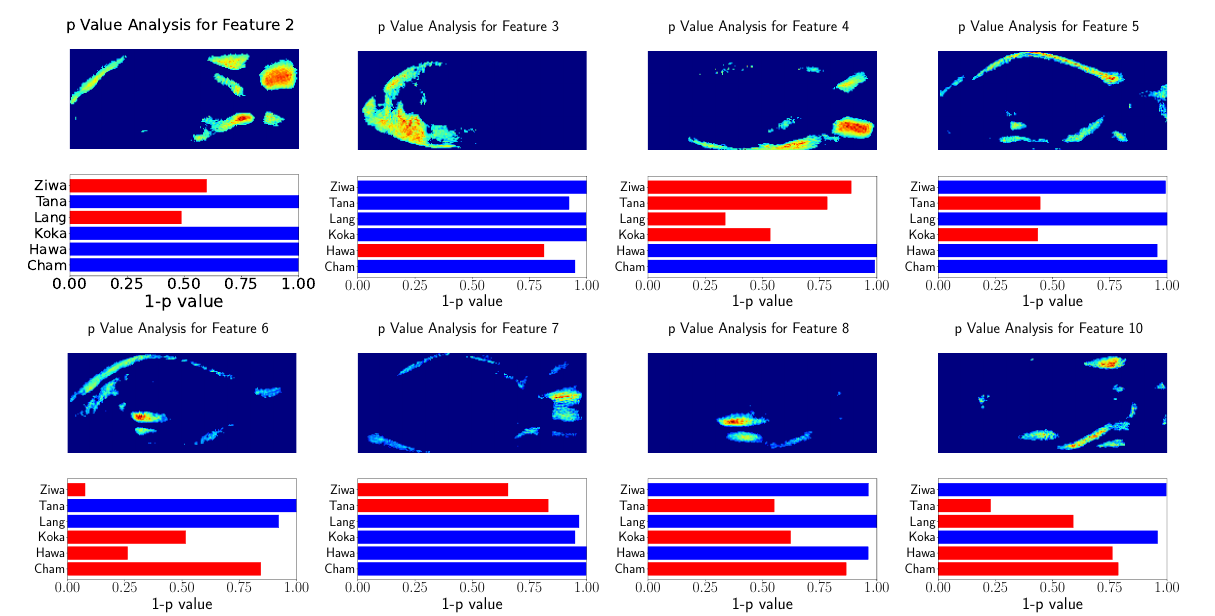
Figure 8. Result of Spearman’s rank correlation test for the relation between the manually selected GP-LVM features and population locations in Ethiopia. The features with highest ARD values are shown. Features with a p -value above α = 0.1 are shown as red bars.